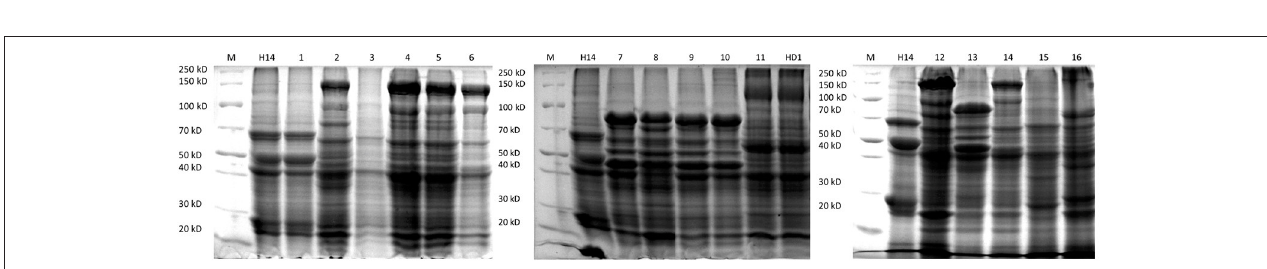
FIGURE 2 | SDS-PAGE gels showing the 16 different protein patterns among the Bt strains collection (1–16). Lanes marked as M is broad range protein marker; H14 is the reference strain Bacillus thuringiensis israelensis and HD1 is the reference strain Bacillus thuringiensis kurstaki ; 1, QBT229; 2, QBT3; 3, QBT6; 4, QBT34; 5, QBT39; 6, QBT212; 7, QBT240; 8, QBT320; 9, QBT418; 10, QBT555; 11, QBT375; 12, QBT41; 13, QBT43; 14, QBT56; 15, QBT81; 16,